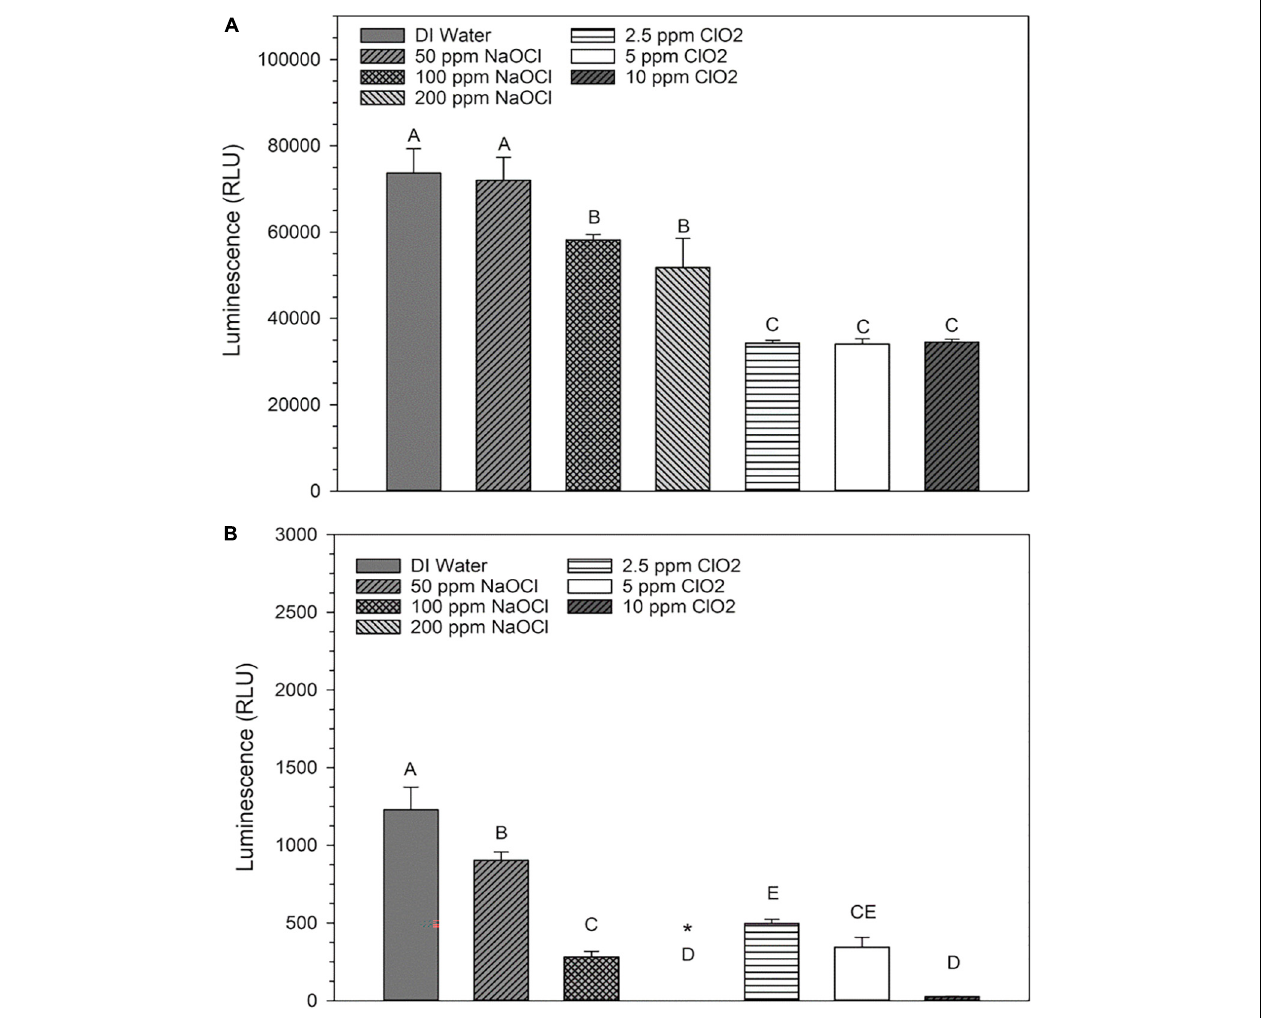
FIGURE 3 | Relative levels of NAD + (A) or NADH (B) present in Escherichia coli O157:H7 after treatment with NaClO or ClO 2 . Data are presented as means ± standard deviations, and significant differences ( P ≤ 0.05) in relative luminosity units (RLUs) observed after each treatment are represented by different letters (e.g., A–E). The symbol “*” represents that the RLU was below the detection limit of the assay.